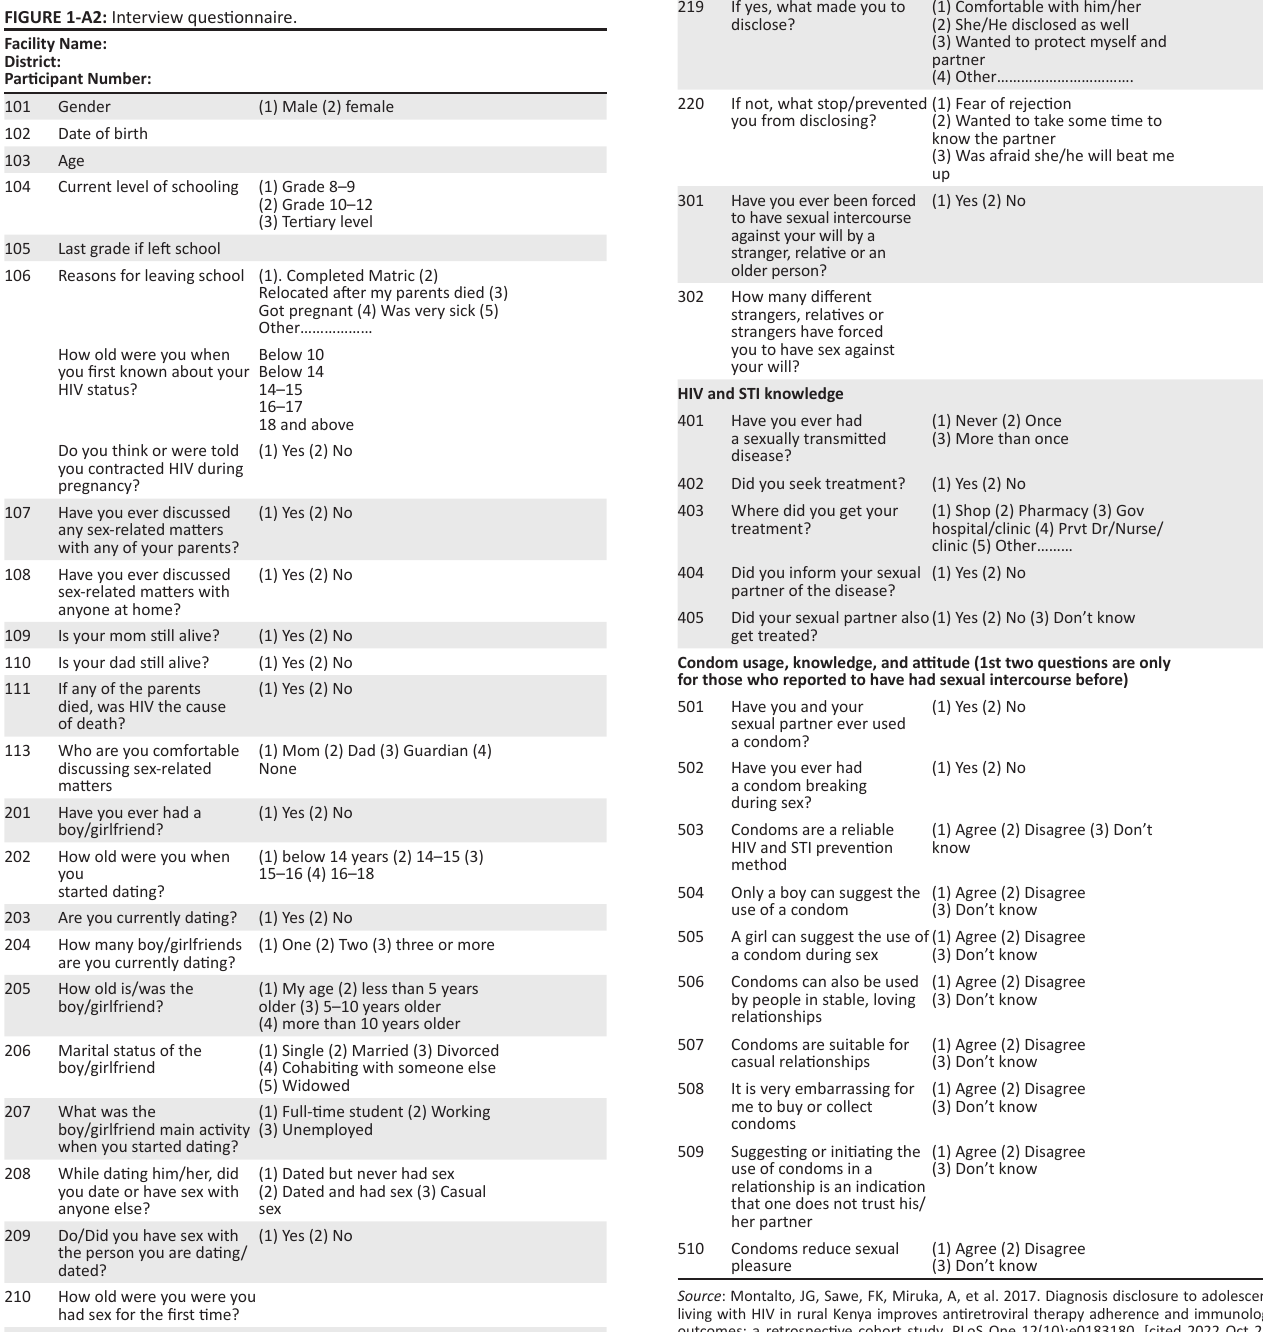
FIGURE 1-A2: Interview questionnaire.